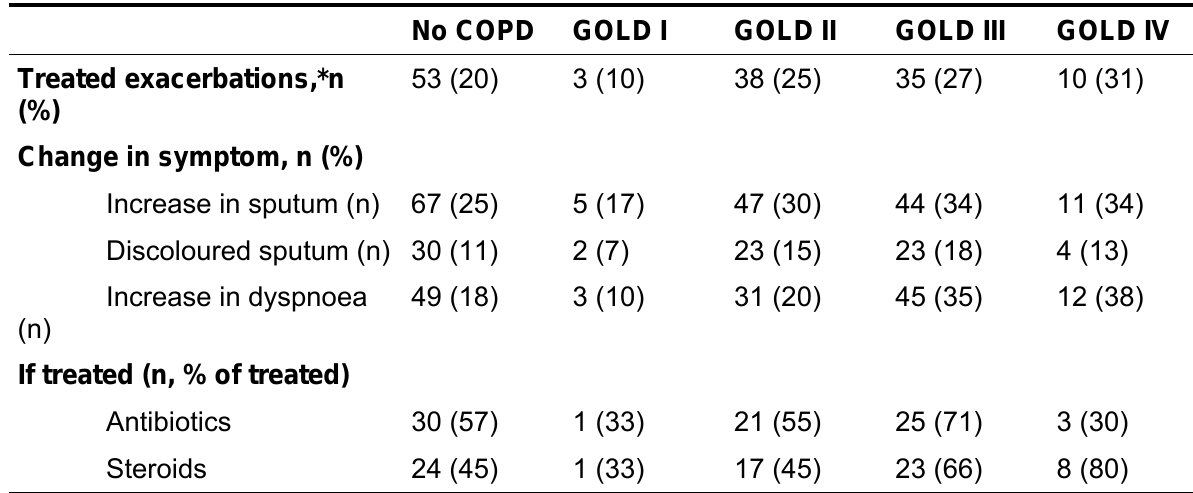
Number of patients with indicators of past